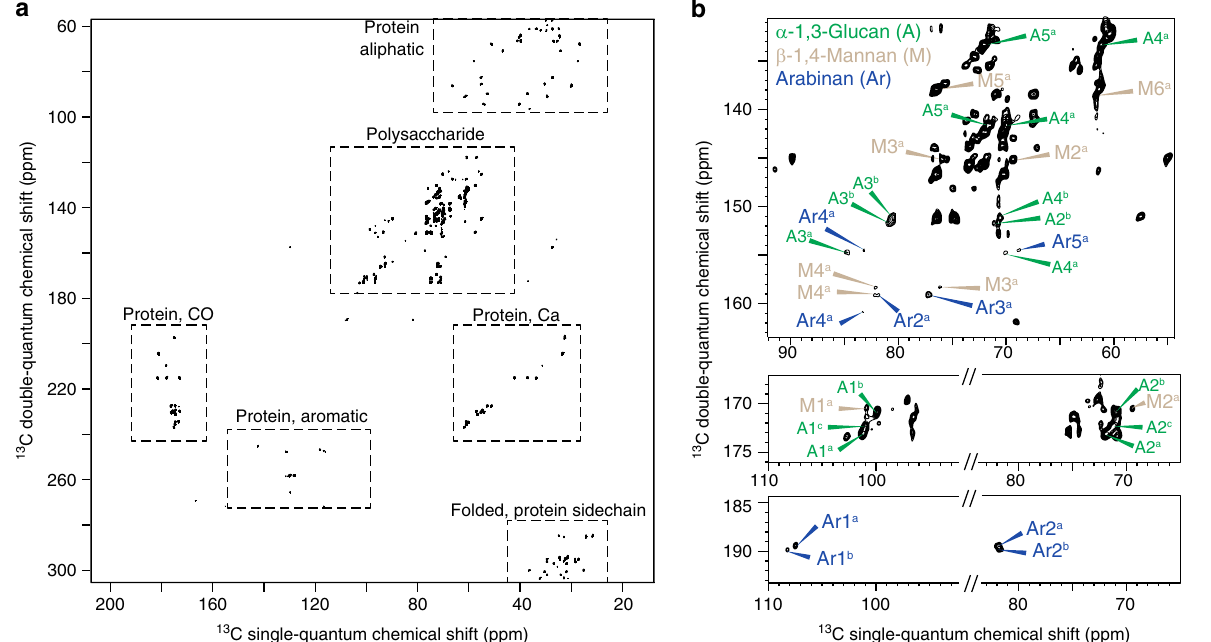
Fig. 6 Glycoprotein and α -1,3-glucan form a highly mobile shell. a 2D 13 C DP J-INADEQUATE spectrum selects only the very mobile molecules of proteins and polysaccharides. b The polysaccharide region reveals the presence of β -1,4-mannan, arabinan and α -1,3-glucan